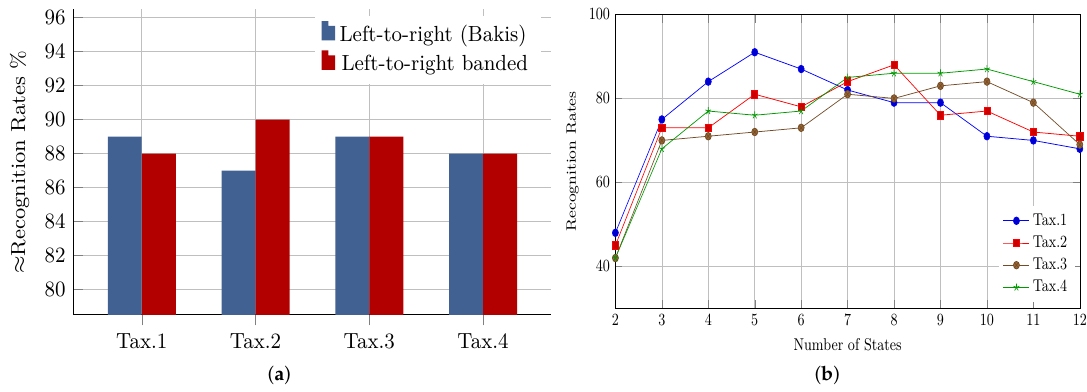
Figure 4. HMM topology and model size optimization: ( a ) left-to-right (Bakis) topology vs. left-to-right banded topology performance; ( b ) effect of HMM model size on